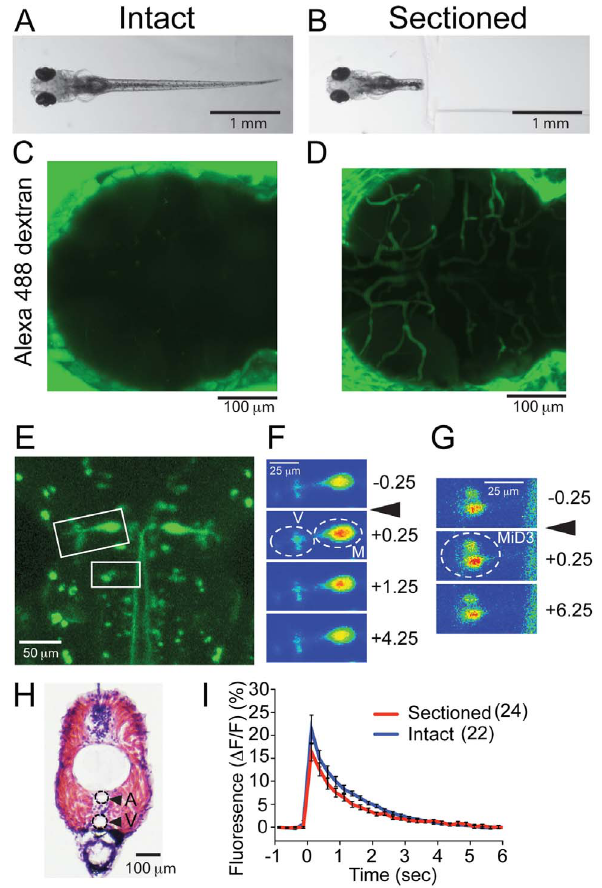
Figure 2. Sectioned larvae compared to intact larvae (A, B). Intact (A) and sectioned larva (B) were immersed in Alexa 488 dextran solution for 30 min. (C, D) Fluorescence images obtained from the cranial region after incubation. In the sectioned preparation, fluorescent dye stained the vasculature. (E–G) Calcium imaging of reticulospinal neurons. Reticulospinal neurons labeled with dextran-conjugated calcium green (E). Intensities of calcium green signal in boxed areas are shown in F and G as pseudocolors. Mauthner neurons (M), vestibulospinal neurons (V) and MiD3 neurons (MiD3) displayed increase of [Ca 2 + ] i after the sound/vibration stimuli (arrowheads). Signals were measured in areas encircled by dashed lines before ( 2 0.25 sec) and after the stimuli ( + 0.25, + 1.25, + 4.25, + 6.25 sec). (H) Image of HE stained larva trunk at the 9 th body segment level. A and V designate artery and vein, respectively. (I) Plots of the fluorescence intensity change in the Mauthner neurons with sound/vibration stimuli. Traces from intact (blue) and sectioned larvae (red) are shown. Six Mauthner cells were measured in each condition. Stimuli were applied and calcium transients were measured at each concentration 2–5